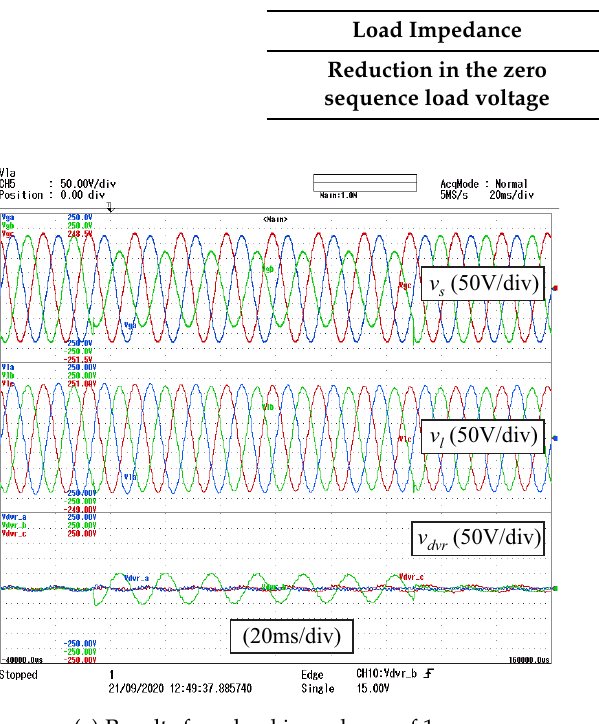
Table 2. Reduction in the zero sequence load voltage for different loads (simulation results).